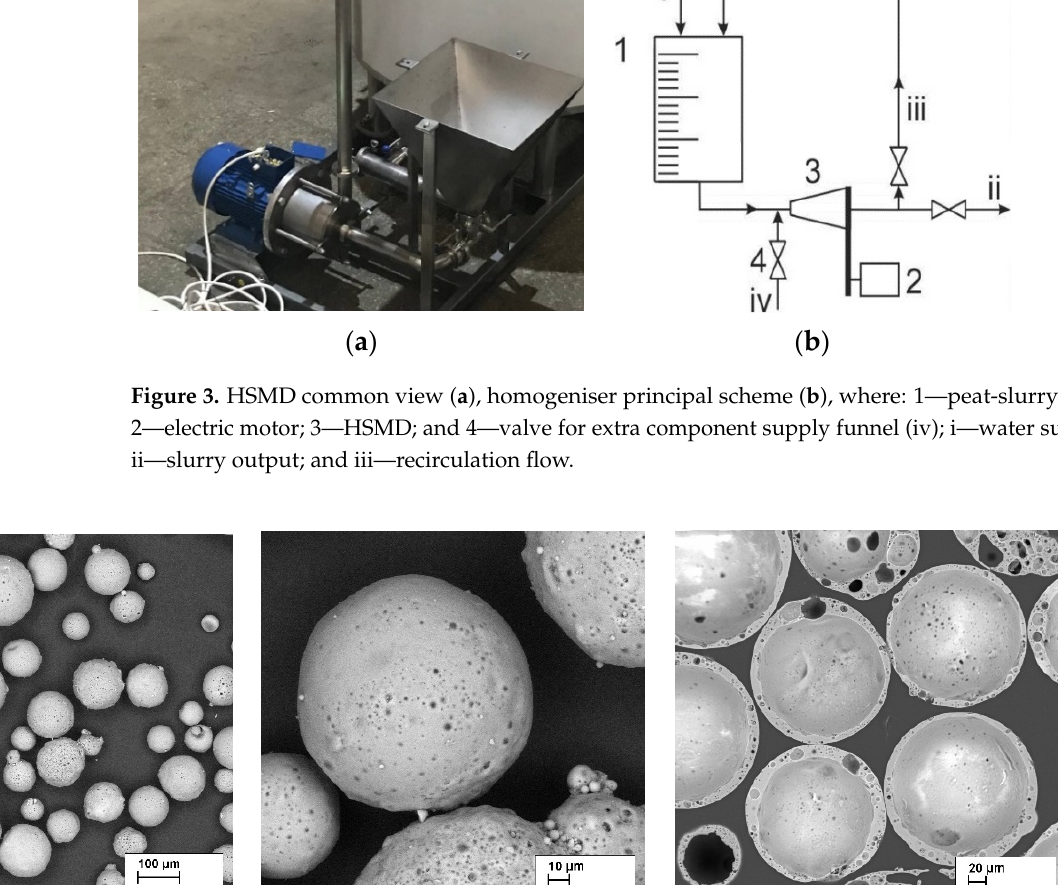
Figure 3. HSMD common view ( a ), homogeniser principal scheme ( b ), where: 1—peat-slurry tank; 2—electric motor; 3— HSMD; and 4—valve for extra component supply funnel (iv); i—water supply; ii—slurry output; and iii—recirculation flow.